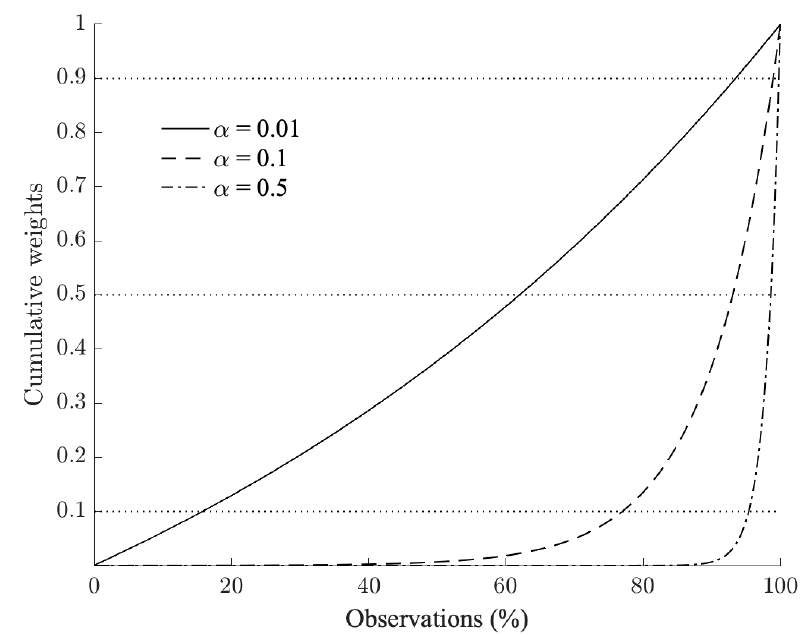
Figure 1. Past information discounting.